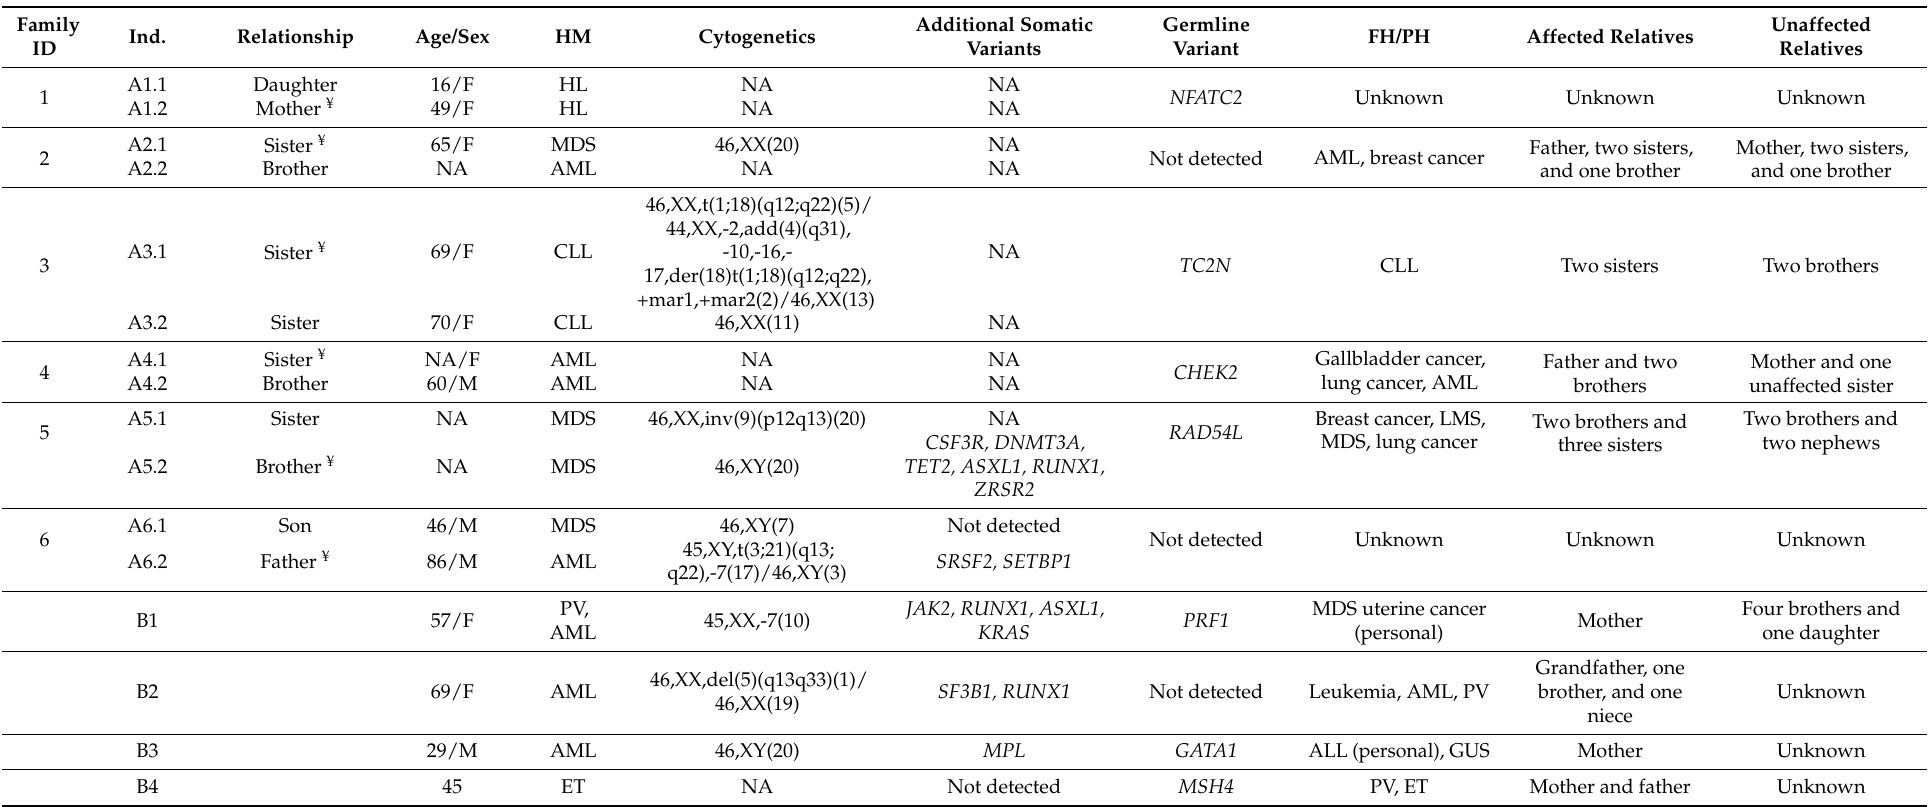
Table 1. Clinical data of the patients included in this